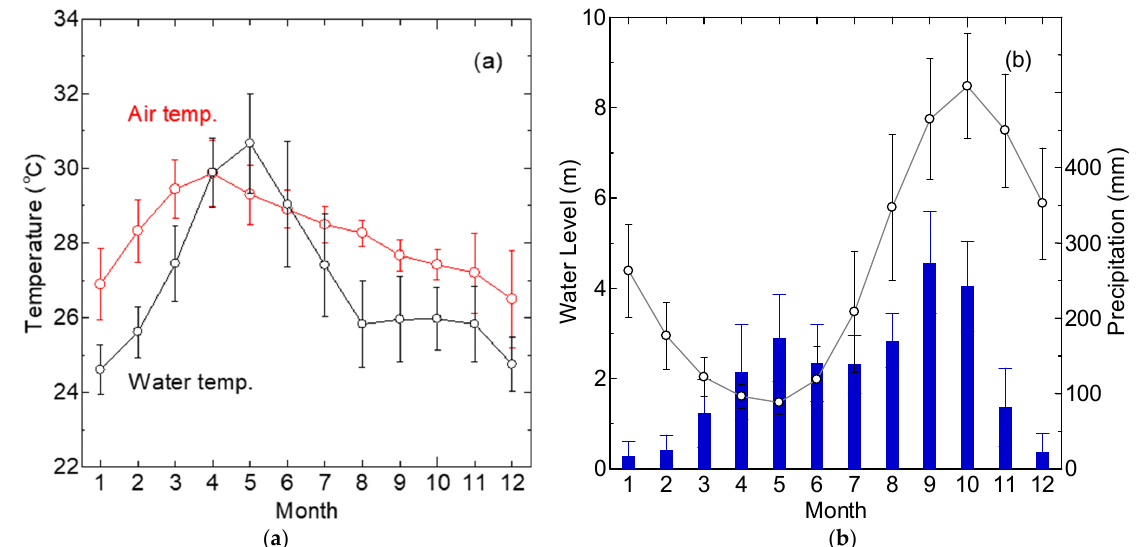
Figure 3. The 20-year mean monthly (a) air temperature and water temperature; (b) precipitation and water level of the Tonle Sap Lake. The bars indicate standard deviation intervals.